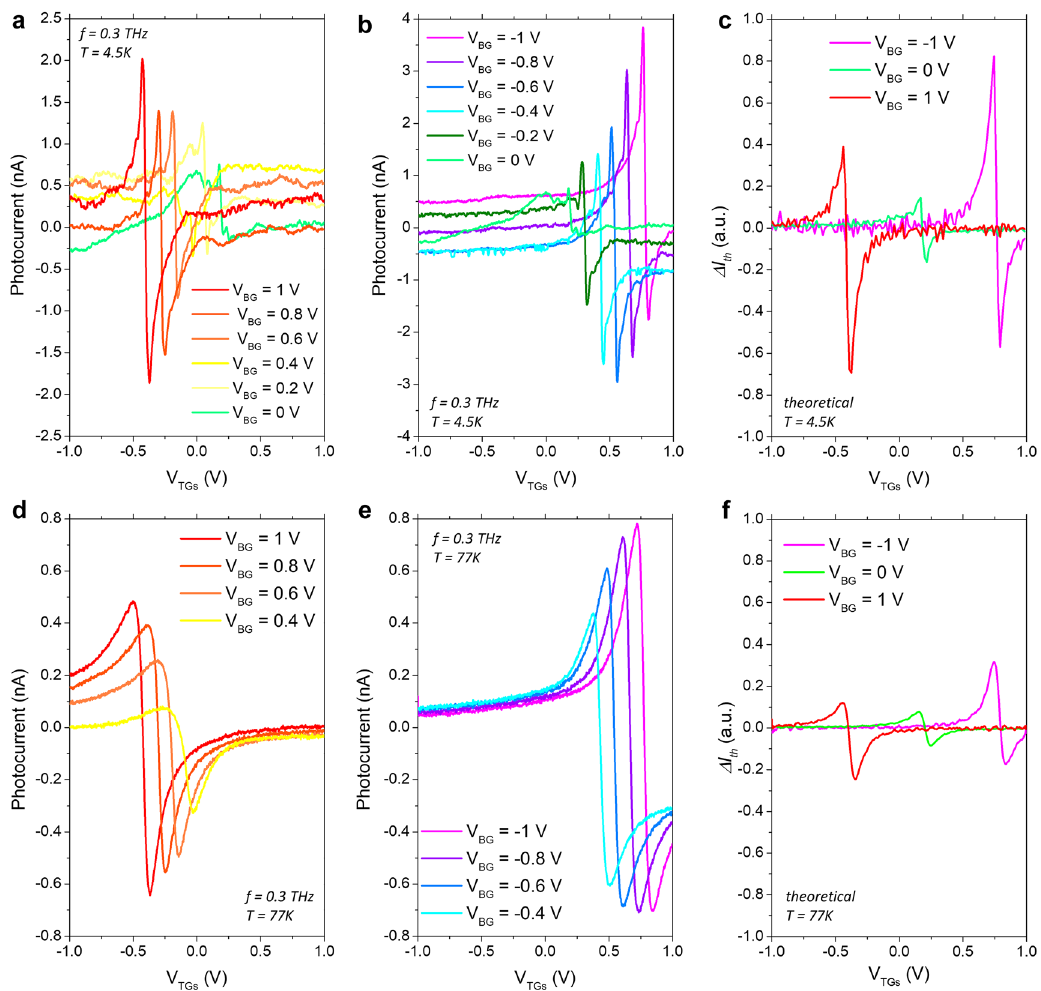
Figure 3: THz photodetection